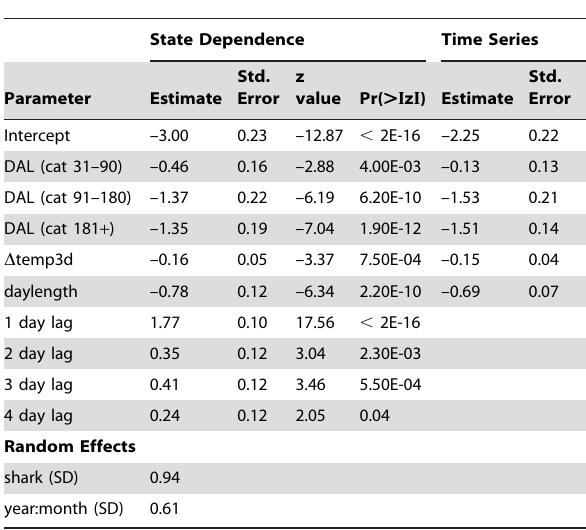
Table 3. Parameter estimates for the best supported state dependence lemon shark residency model. Parameter estimates are also provided for time series modeling for which to compare to state-dependence approach.